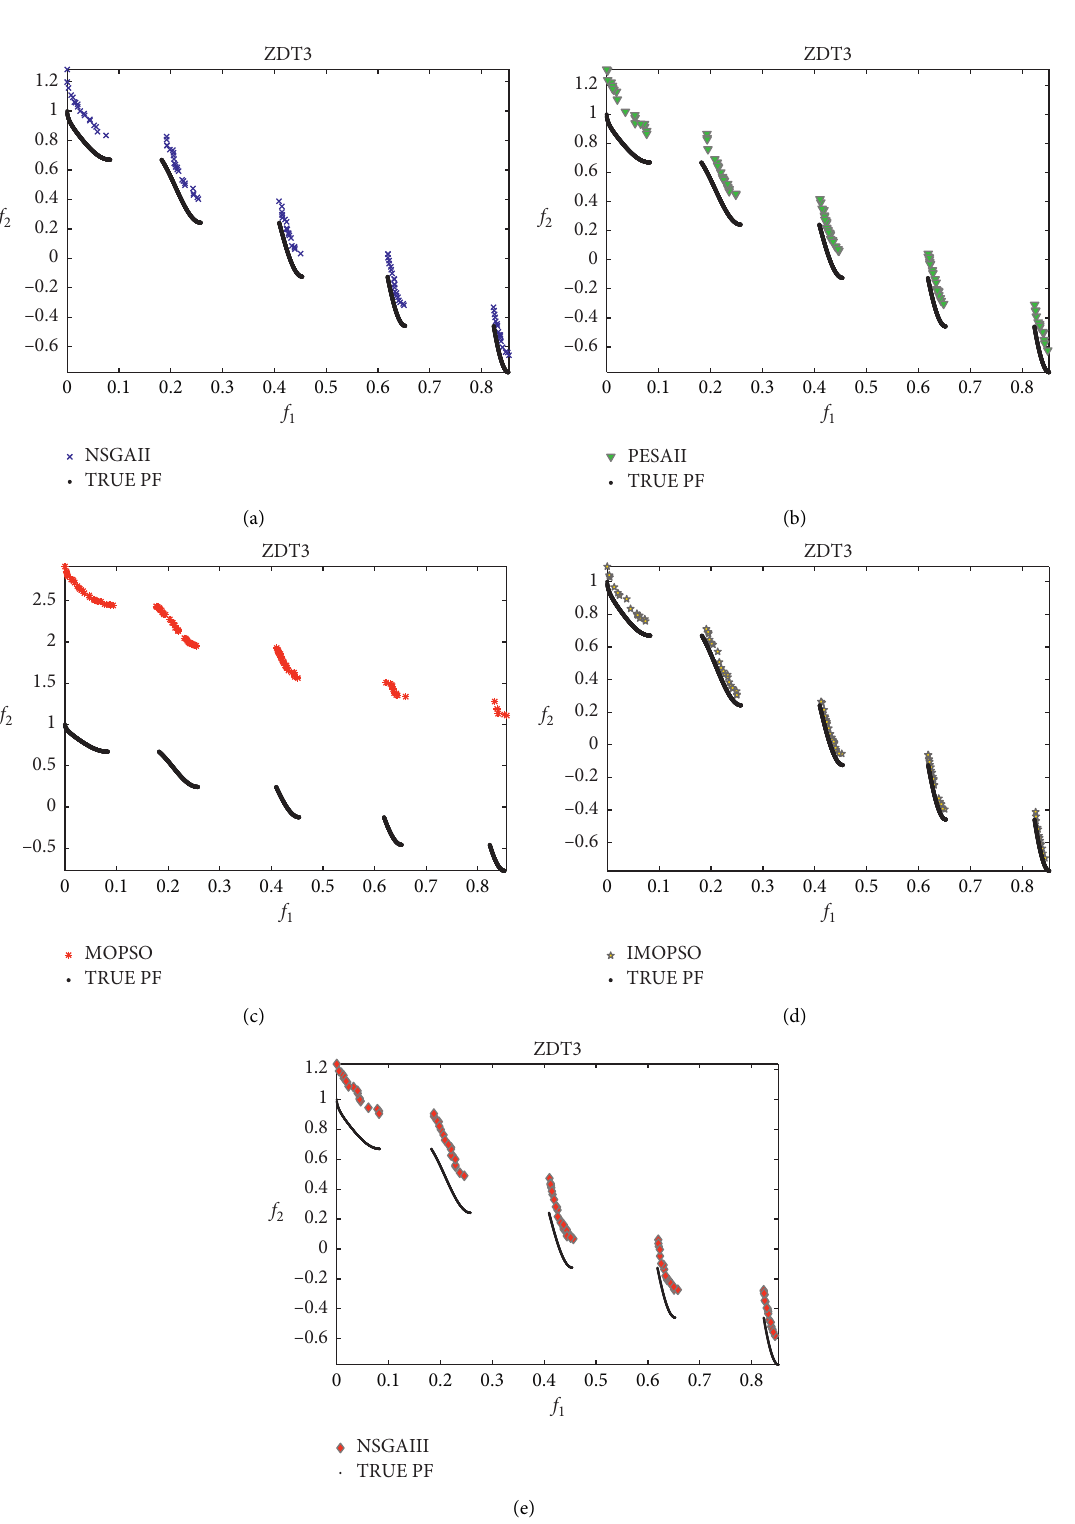
Figure 4: ZDT3 test